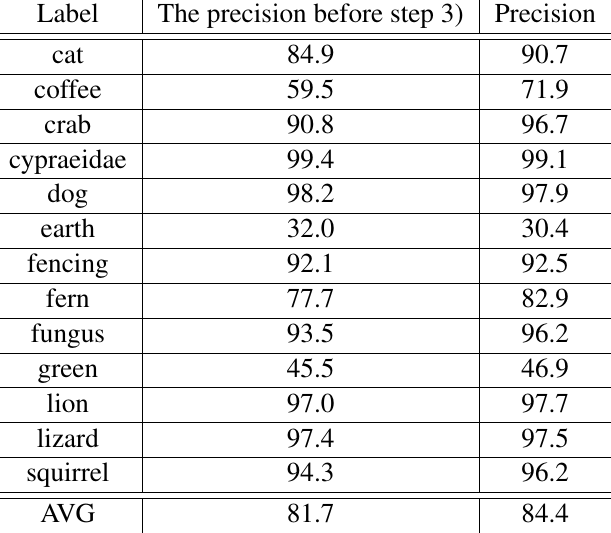
Table 3. The results of the evaluation